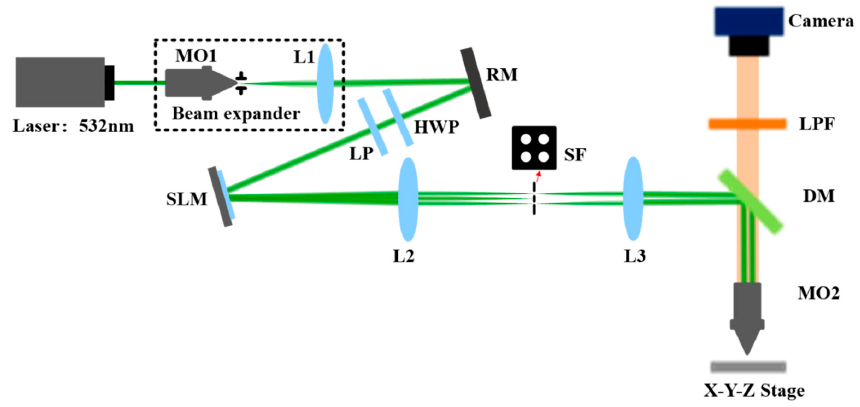
Figure 1. Schematic diagram of the multifocal structured illumination microscope. Abbreviations: MO1–MO2: microscope objective lens; L1–L3, lens from Union Optic with focal lengths of 125, 150 and 150 mm; RM, reflective mirror; HPW, half wave plate; LP: linear polarizer; SLM: spatial light modulator; SF: spatial filter; DM, dichroic mirror; LPF, long-pass filter.